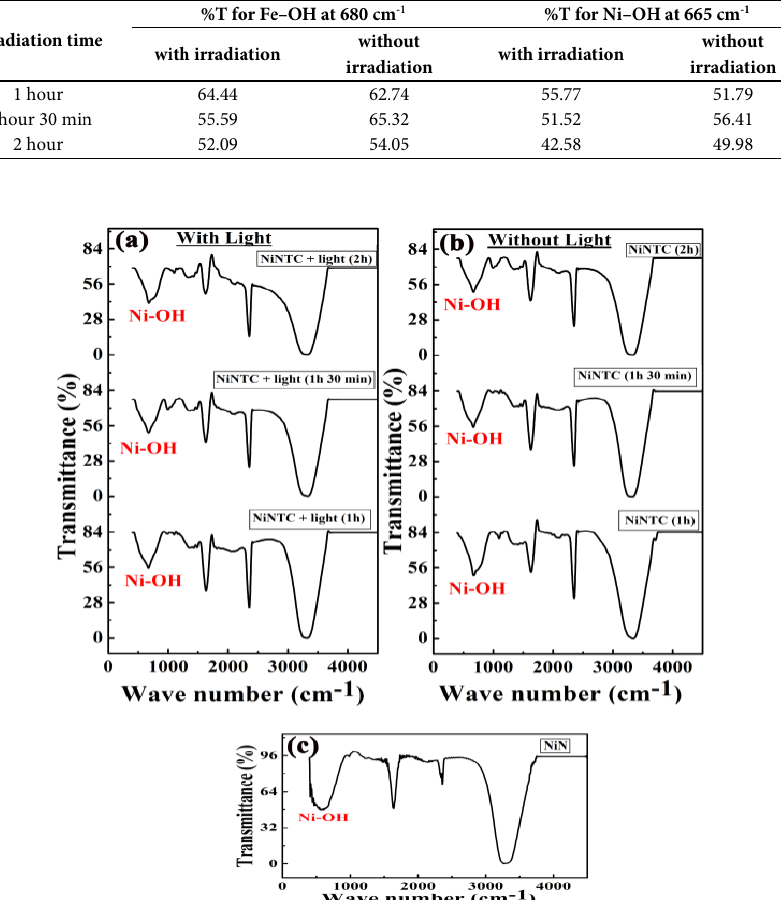
/CuO nanocomposite (a) with light irradiation; (b) without light irradiation; (c) 2 FTIR spectra of untreated nickel